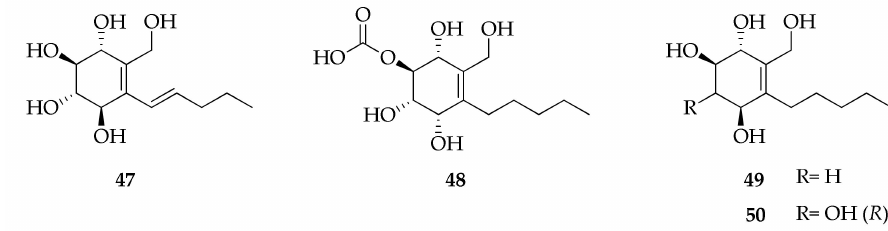
Figure 11. Structures of cyclohexene